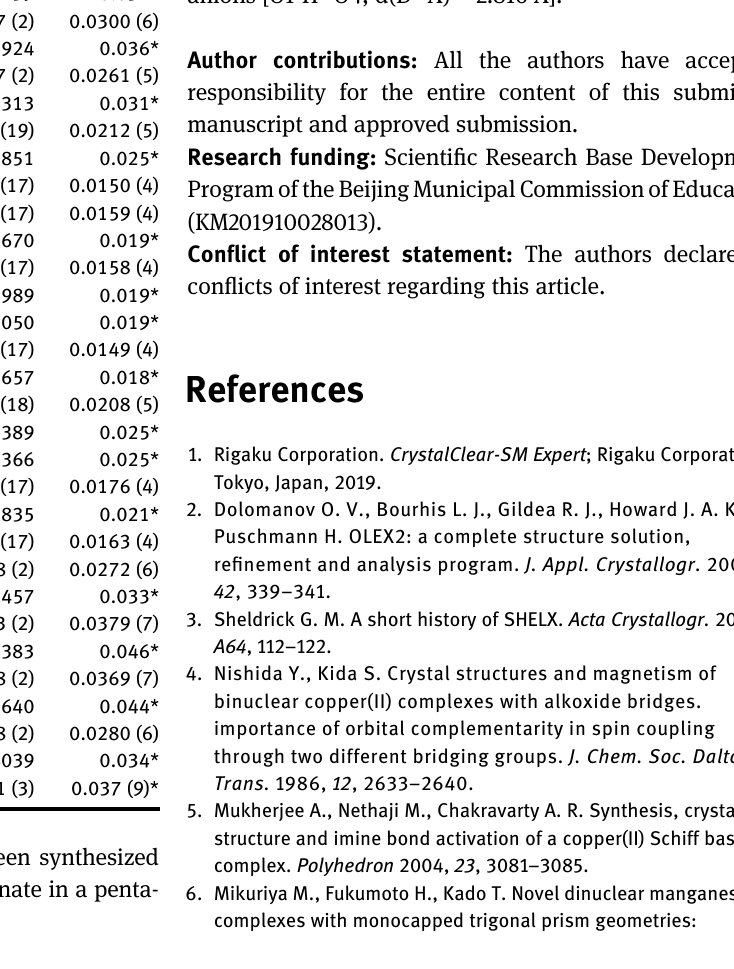
The thermal ellipsoid plot of the title complex is shown ) ] is composed in the figure. The structure of [Ce(HL)(NO 3 3 of a cerium(III), one HL and three nitrate ligands. The central cerium(III) is 11-coordinated with fi ve atoms (N1, N2, N3, N4, O1) of HL and six oxygen atoms (O2, O3, O5, O6, O8, O9) from three bidentate coordinating nitrates. In this complex HL is not deprotonated as expected and exhibits a bent coordination with the angle between the two pyridine rings to be 80.5 ° . The Ce – O (hydroxyl) distance is 2.6498(16) Å. The two imine nitrogen atoms of HL form shorter bonds at 2.6572(18) Å for Ce1 – N2 and 2.6375(19) Å for Ce1 – N3, while the pyridine nitrogen atoms of HL form longer bonds at 2.7551(18) Å for Ce1 – N1 and 2.7643(19) Å for Ce1 – N4. The bond angles of the pentadentae ligand HL around the cerium(III) are 61.05(6) ° for N1 – Ce – N2,